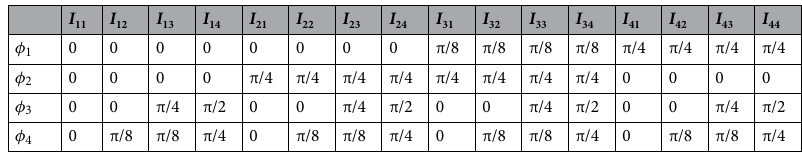
Table 1. Angles of the polarimeter waveplates